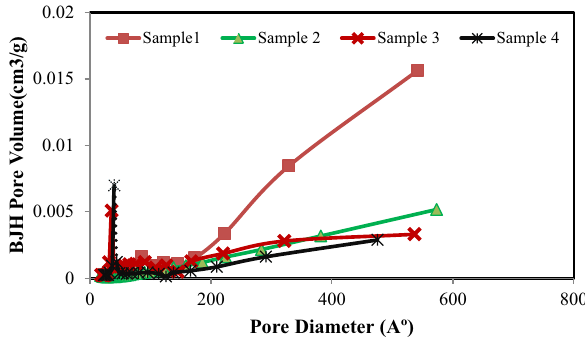
Fig. 7 BJH Pore size distributions of Permian